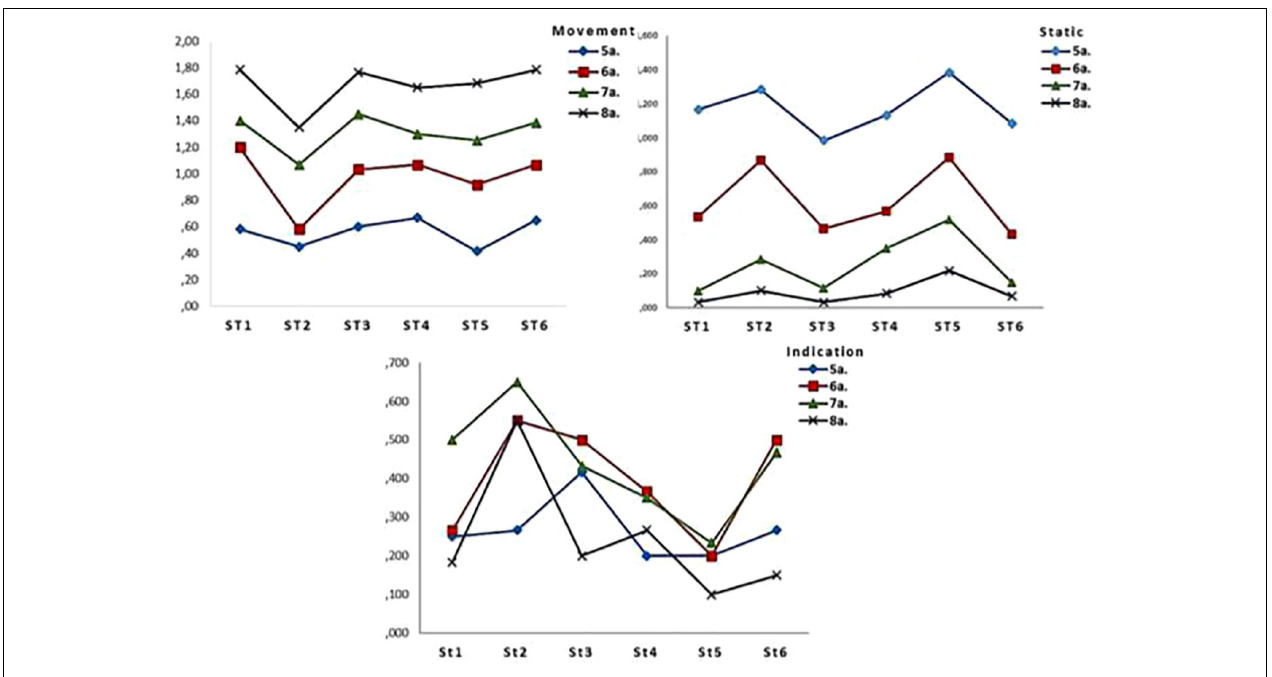
FIGURE 2 | Representation of macrocategories according to